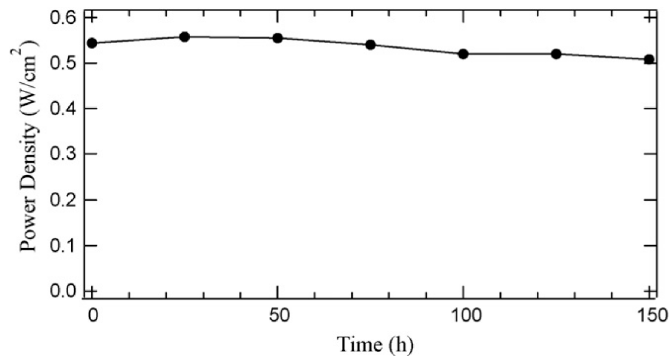
Figure 11. Time dependence of the power density at 700 °C and 0.7 V. (Reprinted with permission from [36], 2008,